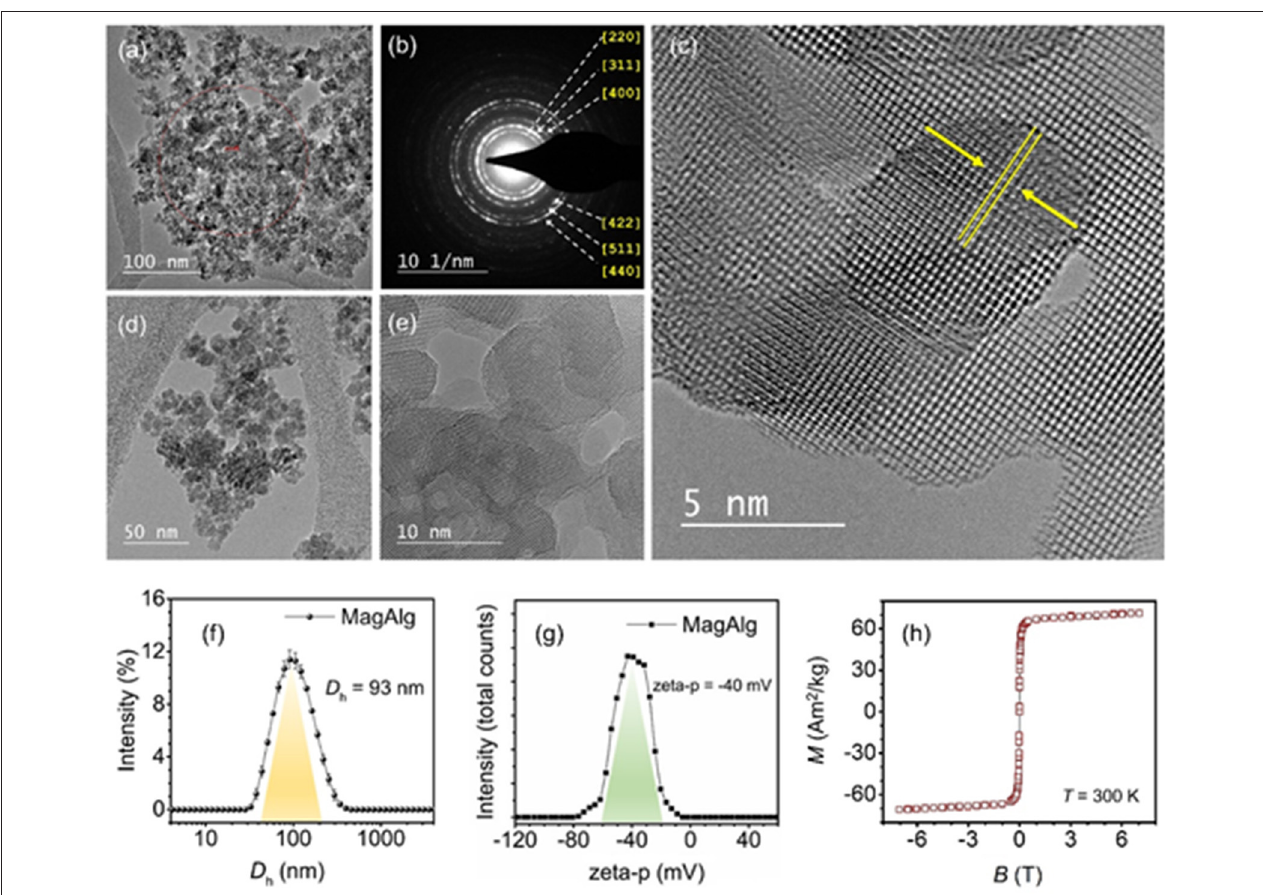
FIGURE 2 | (a–e) HR-TEM micrographs of the MagAlg MNPs. (b) shows the SAED pattern, with diffraction rings indexed for inverse spinel iron oxide (maghemite phase). (c) the crystalline planes, [311], are highlighted by arrows. (f) shows the intensity distributions of the mean hydrodynamic diameter and (g) the zeta potential in water of the MagAlg nanoparticles. (h) shows the saturation magnetization ( Ms ) vs. applied field ( B ) for MagAlg recorded at T =